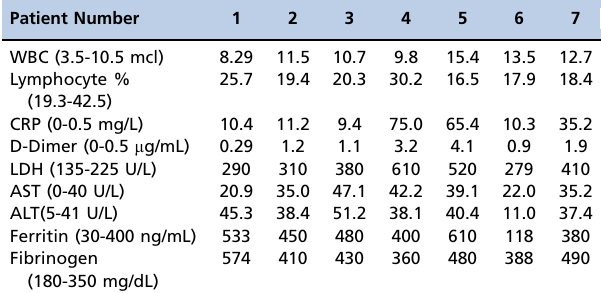
Table 2 - Laboratory data of patients.